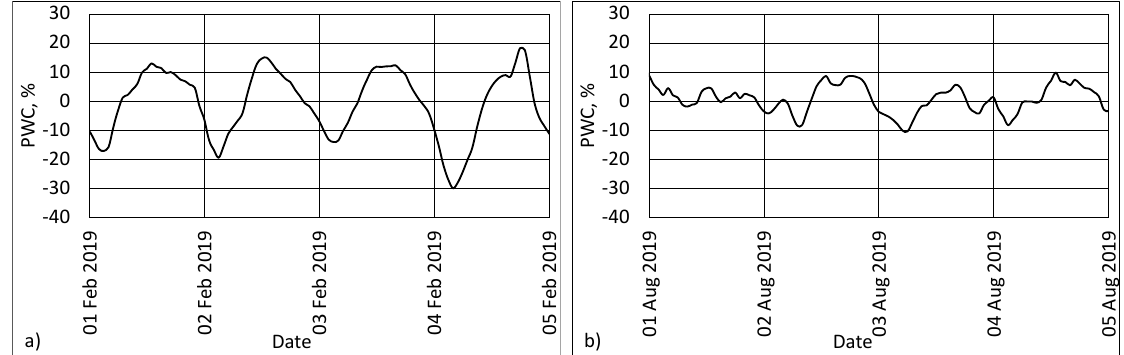
Figure 12. PWC (percentage of water volume change) values for typical winter ( a ) and summer ( b ) days.